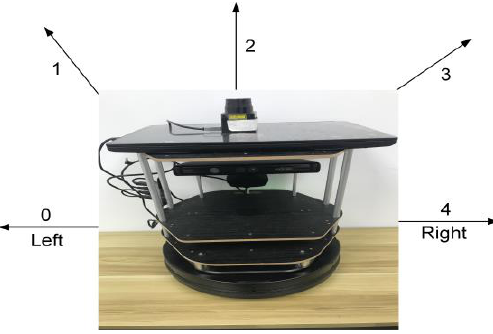
Figure 3. Mobile robot actions direction, where 0 is left (−90°), 1 is left front (−45°), 2 is front (0°), 3 is right front (45°) and 4 is right (90°). Table 1. Action and angular velocity.